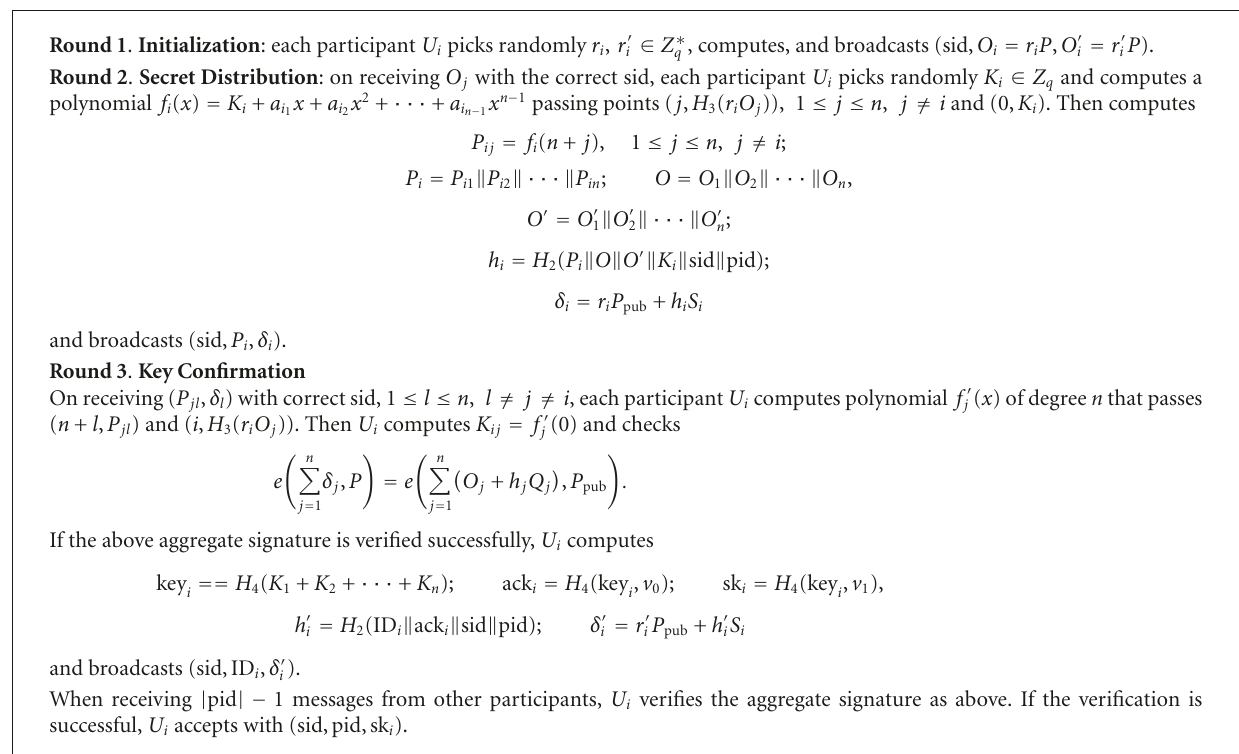
Algorithm 3: The UC-secure GKE protocol